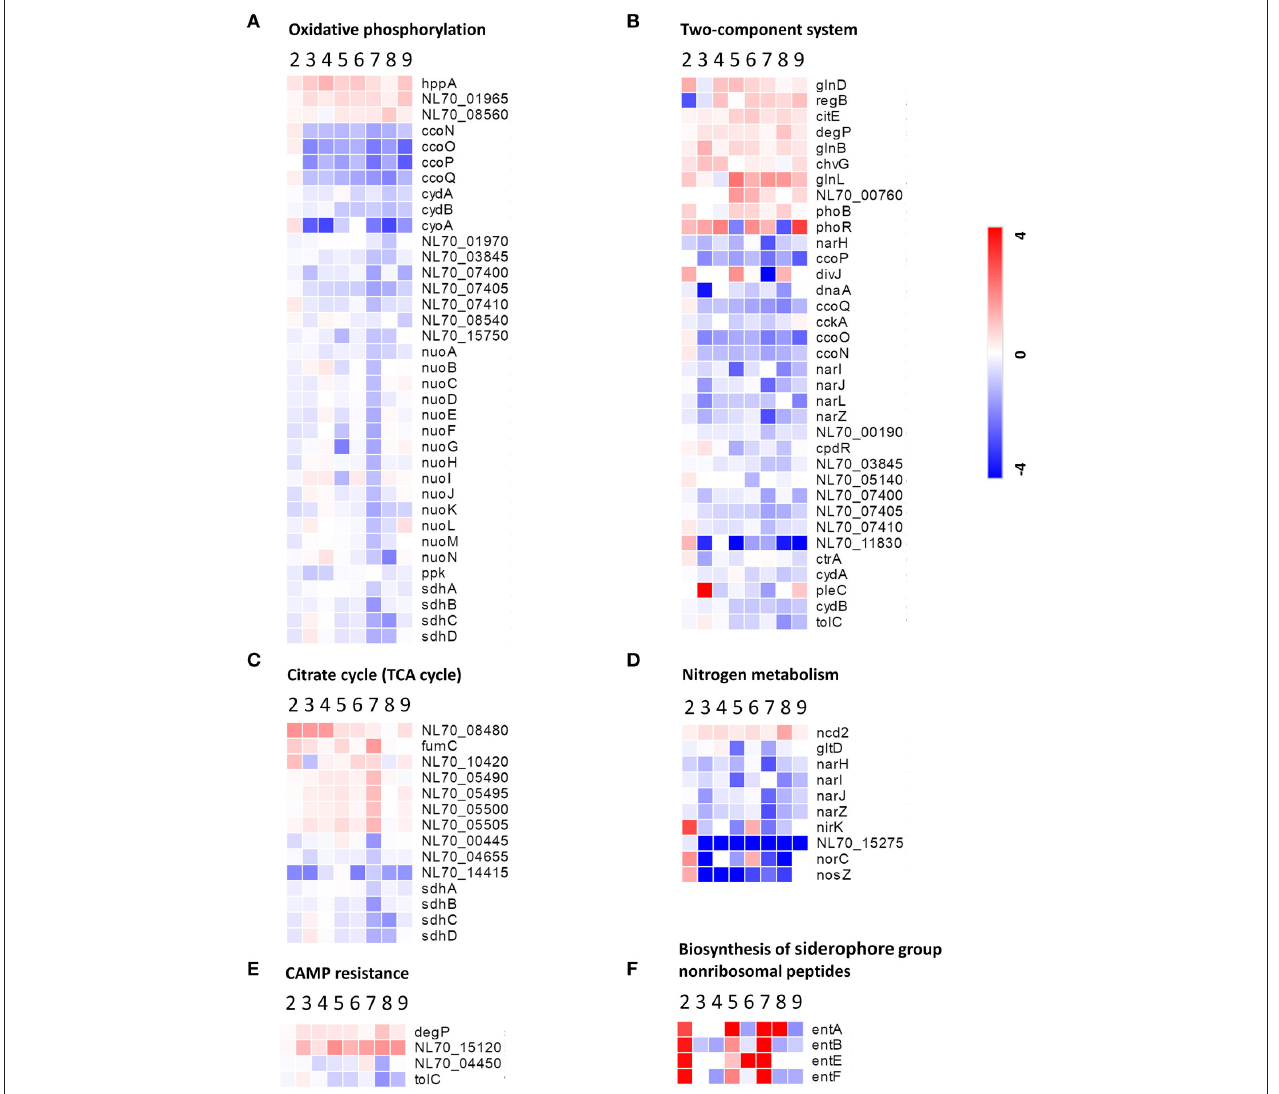
FIGURE 6 | Heatmap of DEPs related to the main metabolic changes of B. abortus in response to stress treatments. Fold change of proteins related to (A) oxidative phosphorylation, (B) two-component systems, (C) the citric acid cycle, (D) nitrogen metabolism, (E) cationic antimicrobial peptide resistance, and (F) biosynthesis of siderophore group nonribosomal peptides. The heatmap is shown in matrix format with rows representing the individual proteins and columns representing each stress condition. The red and blue colors reflect high and low fold changes,